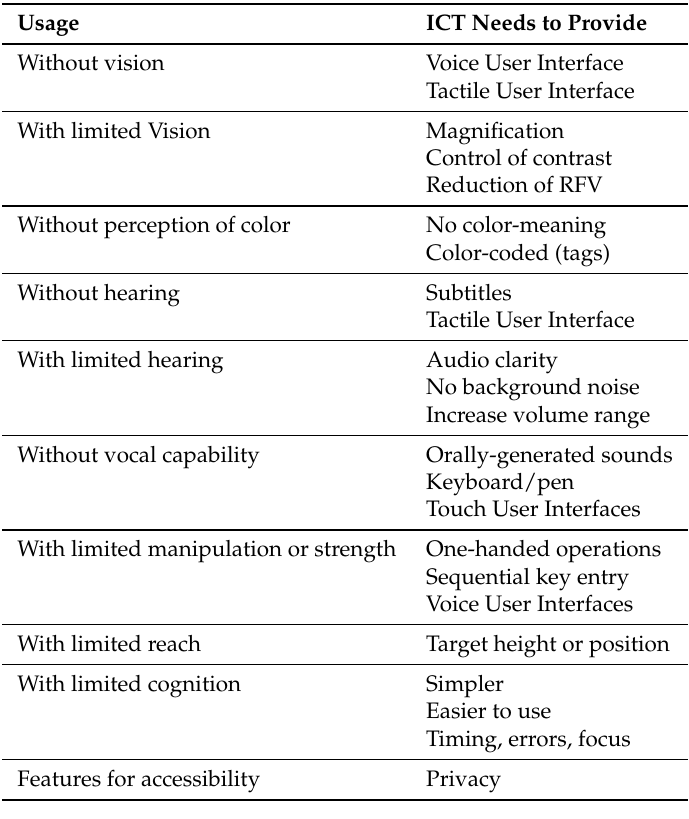
Table 2. Functional performance